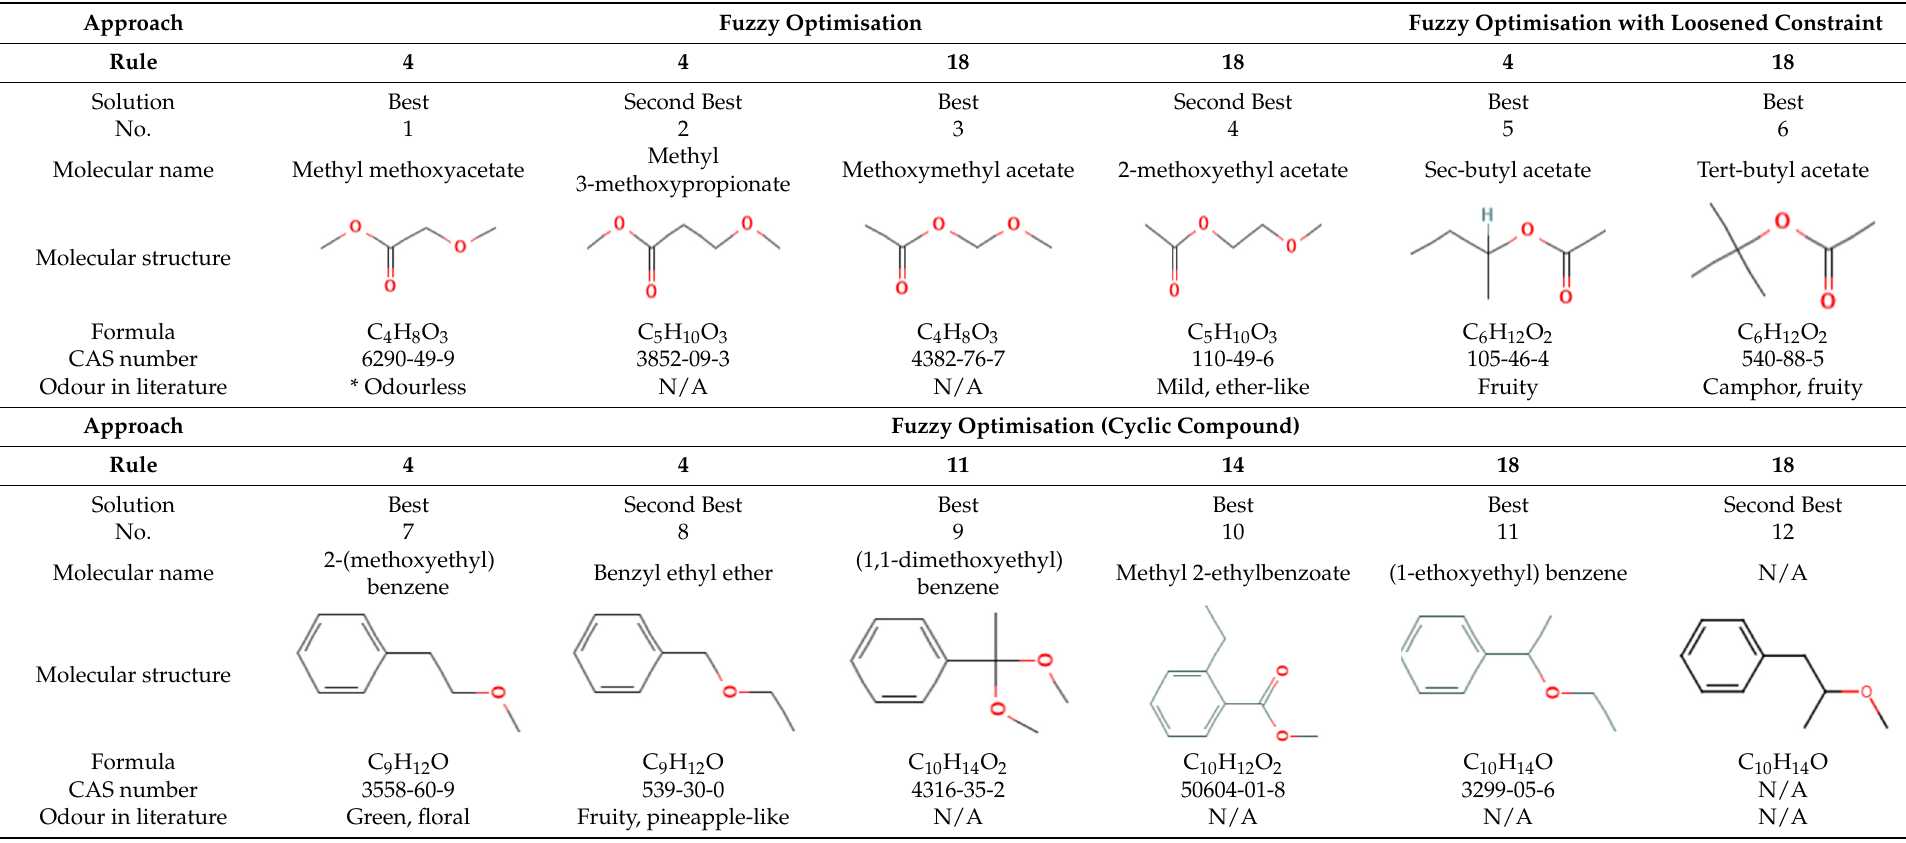
Table 10. Fuzzy optimisation results.